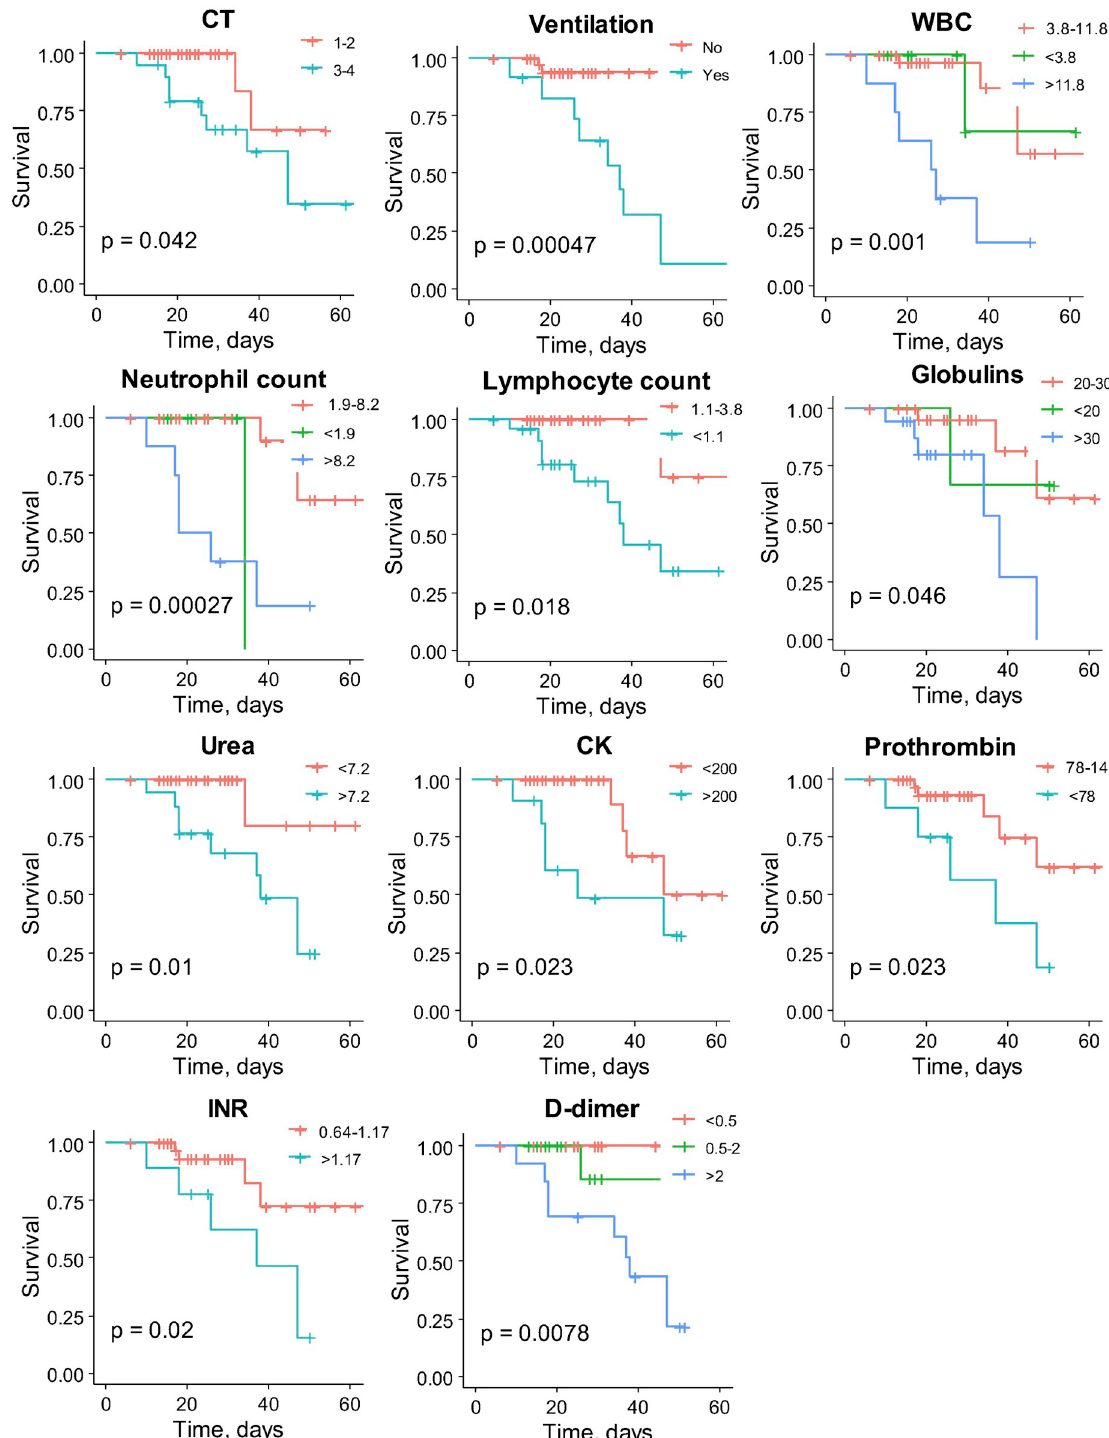
Fig 2. Kaplan-Meier survival curves for patients grouped by clinical and routine blood test parameters. The fraction of survival is expressed on the y-axis, while time (days) of the observation period is expressed on the x-axis. Vertical traits indicate censored data (hospital discharge). P values of log-rank tests are indicated for each graph. Reference group is shown in red.